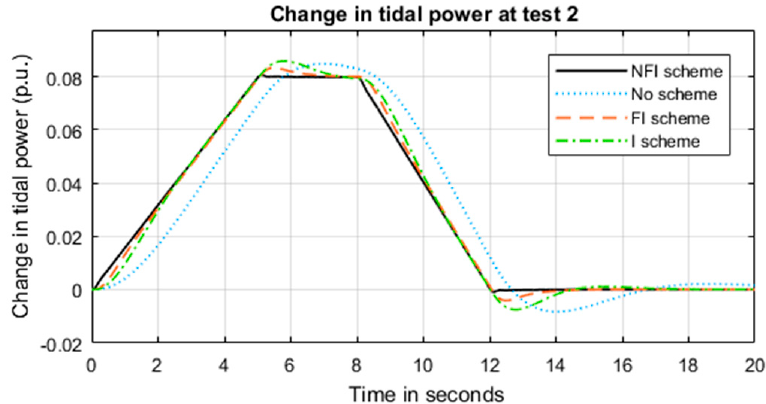
Figure 18. Change in tidal power in test 2.